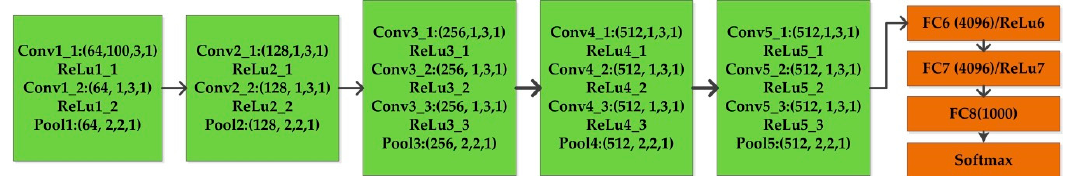
Figure 2. The architecture of VGG16: The green boxes indicate the convolutional blocks, and the brown boxes represent the fully connected blocks. The four numbers that occur after each layer indicate the output number of the feature map, padding, kernel size, and stride, respectively.